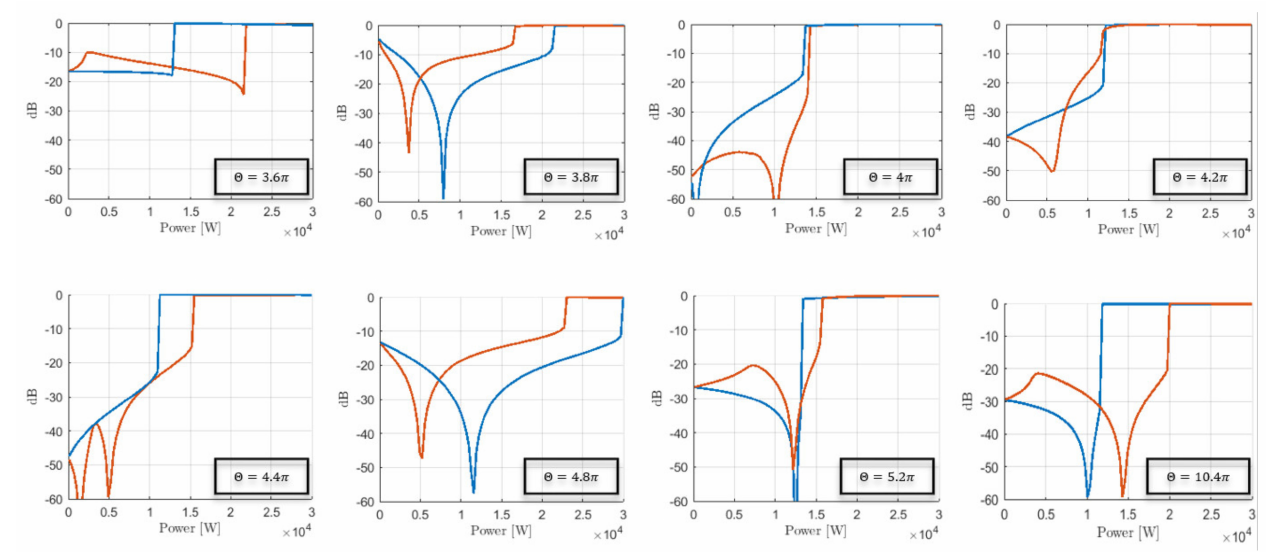
Figure 8. Full wave simulation results for the nonlinear device in the inset of Figure 7b, excited at frequency c/1.56104 [um] with a normally incident plane wave of power P inc for the different values of θ displayed in the bottom right corner of each figure. The horizontal axis is normalized by the period p = 1.475 µ m such that it has units of